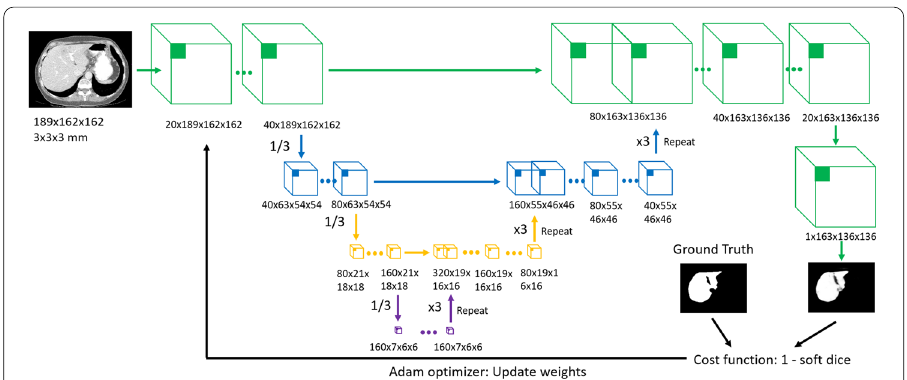
Fig. 2 Overview of the CNN structure. The model consists of four resolution hierarchies with three skip connections. The input image has the voxel size of 3 × 3 × 3 mm 3 . The input image size is 189 × 162 × 162 , and the output image size is 163 × 136 × 136 . The up- and down-sampling rate is three, and the up-sampling is implemented by repetition. The convolutional kernel size for all layers is 3